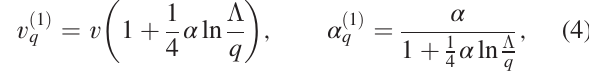
FIG. 1. Plot of the function F that controls, via Eq. (3), the value of the constant C 3 for the RPA van der Waals interaction between graphene